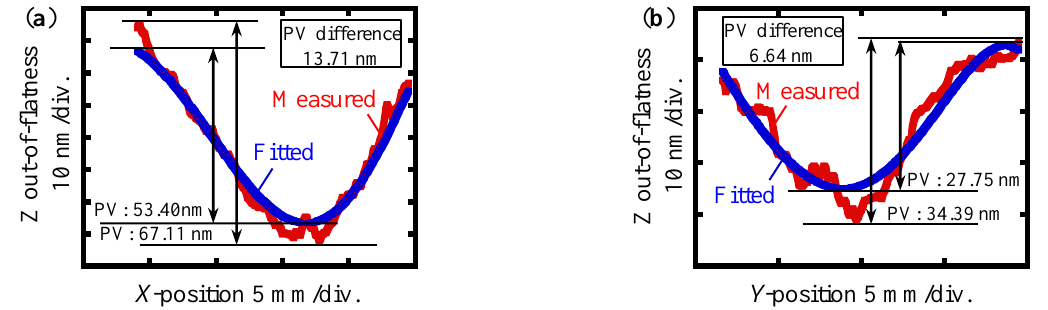
X -position 5 mm/div. Figure 5. Measured and fitted results of the Z -directional out-of-flatness. ( a ) Measured Z -directional out-of-flatness; ( b ) Z -directional out-of-flatness fitted by a polynomial. PV: peak-to-valley.